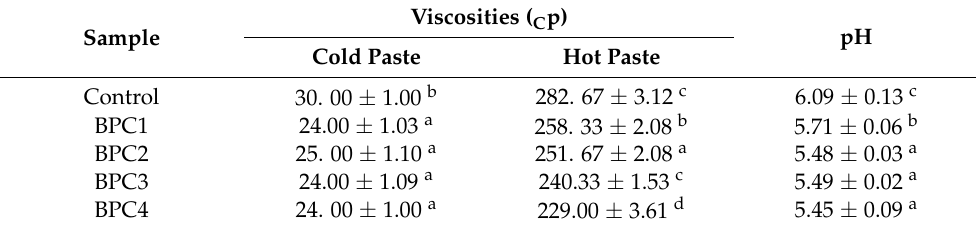
Table 2. Viscosity and pH analysis of composite flours.